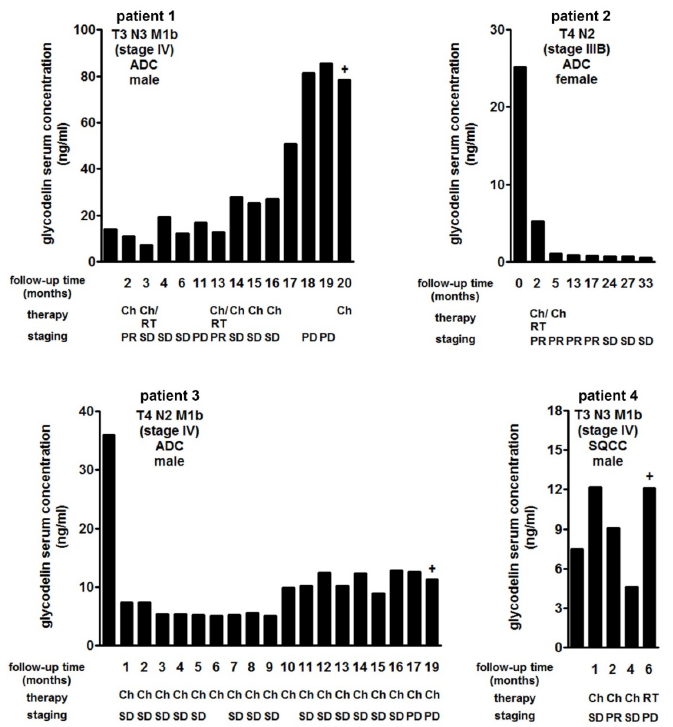
Figure 5. Glycodelin serum concentrations during patient follow-up. Glycodelin serum concentrations of four NSCLC patients during disease follow-up. Therapy response was defined by clinical staging. SD = stable disease, PR = partial remission, PD = progression disease, Ch = chemotherapy, RT = radiotherapy, + = time of death.